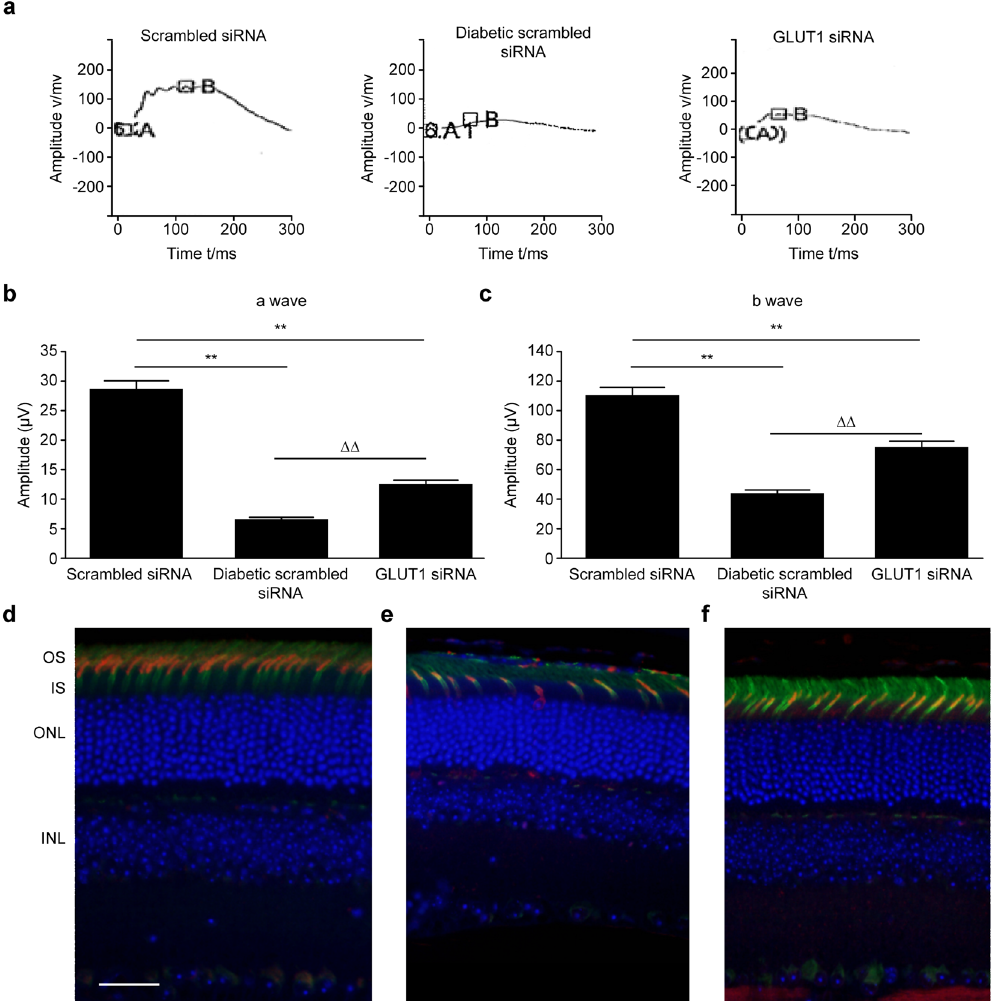
cells of the three groups were detected using an immunofluorescence colocalization method (fluorescence microscope × 400) ( d ) scrambled siRNA group, scale bar represents 50 µ m; ( e ) diabetic scrambled siRNA group; ( f ) GLUT1 siRNA group; green: PNA, red: opsin, blue: DAPI; OS: outer segment of cone cell; IS: inner segment of cone